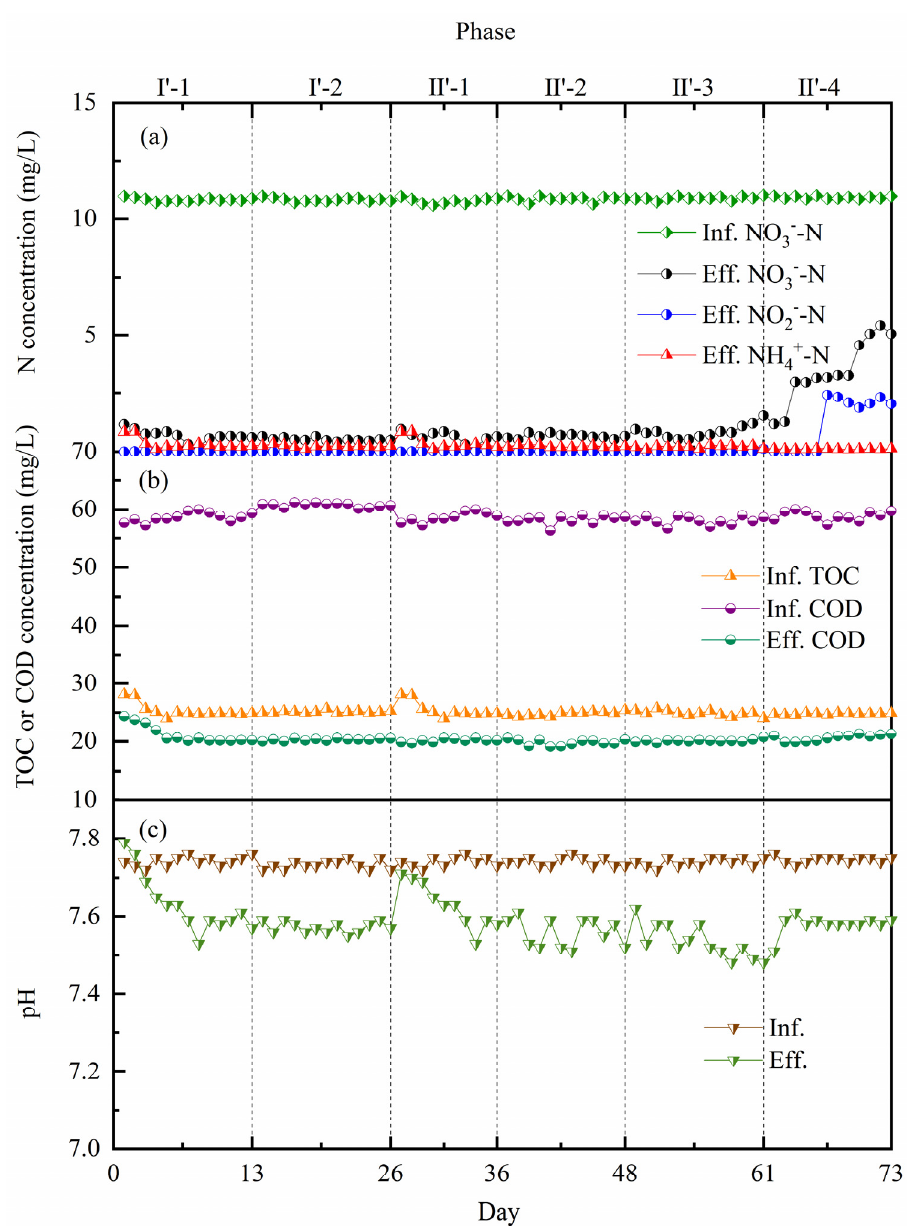
Figure 2. Changes in ( a ) nitrogen species, ( b ) COD or TOC, and ( c ) pH concentrations in denitrifying reactor B during the entire operation.